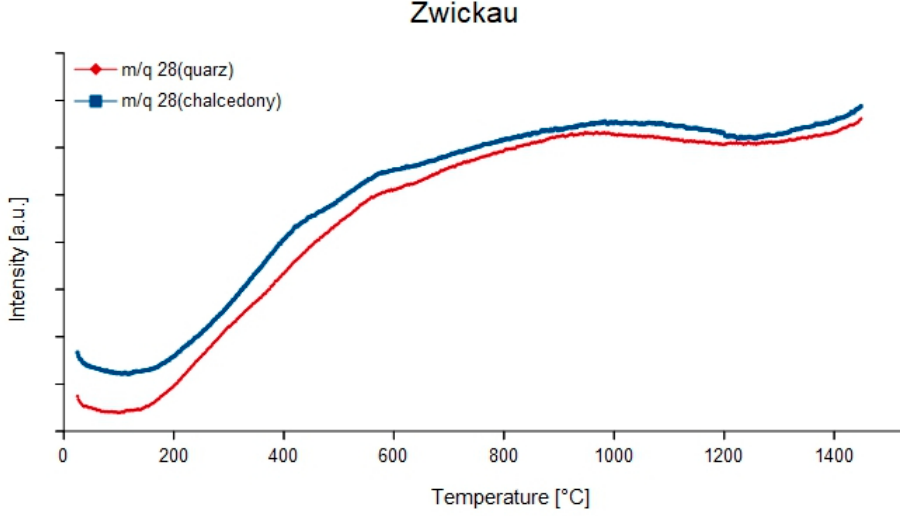
Figure 10. Continuous degassing curves of mass-charge ratio 28 ( 12 C 16 O) of the quartz and chalcedony parts in the agate from Zwickau, Germany.